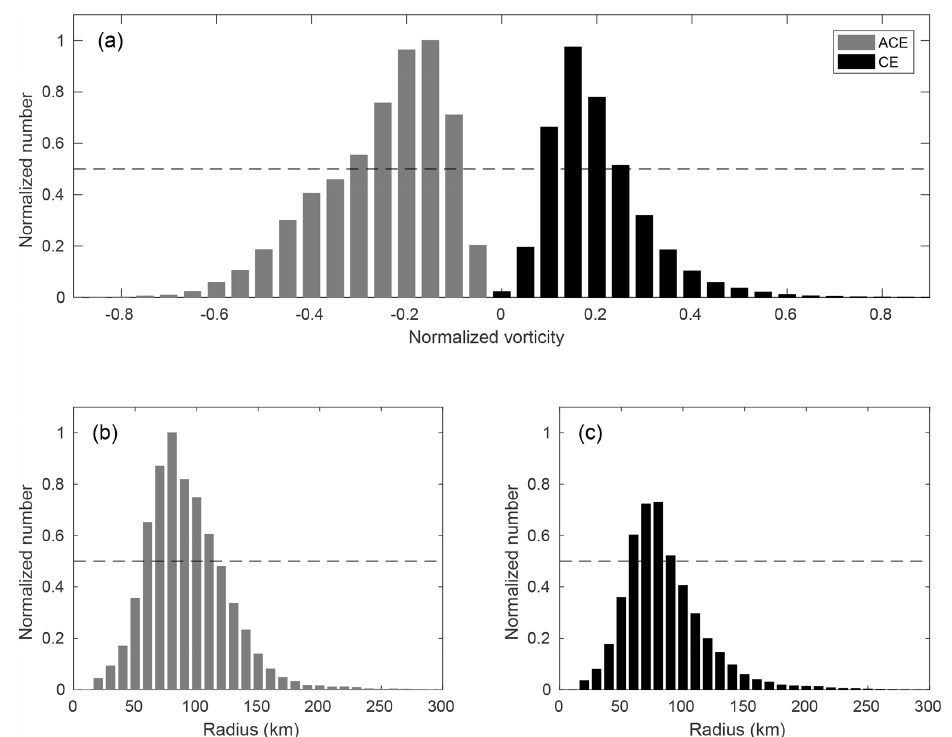
Figure 6. (a) Histogram of eddy vorticity for eddies with a lifetime longer than 7d for the time interval between 1993 and 2016 with a bin width of 0.05. Cyclonic eddies (CEs) and anticyclonic eddies (ACEs) are mirrored for better visualization. The eddy vorticity is normalized to the local Coriolis parameter. (b) Histogram of eddy radius for anticyclonic eddies with lifetimes longer than 7d during the time interval from 1993 to 2016. (c) Histogram of eddy radius for cyclonic eddies with lifetimes longer than 7d during the time interval from 1993 to 2016. The number of eddies has been normalized to the maximum number of anticyclonic eddies (736 ACEs with a radius of 80km). The thick gray line depicts a normalized number of 0.5.